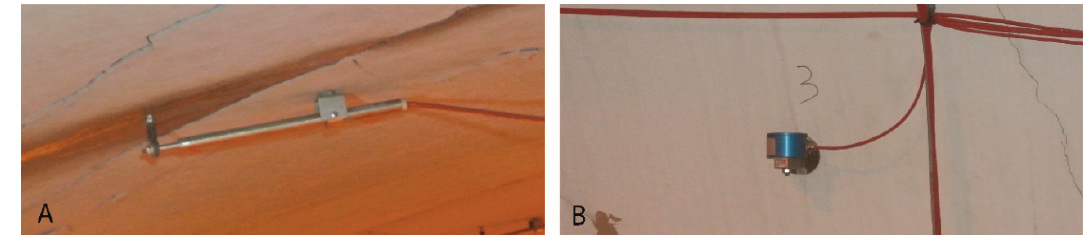
Figure 6. An extensometer ( A ) and a clinometer ( B ) installed in the tunnel.